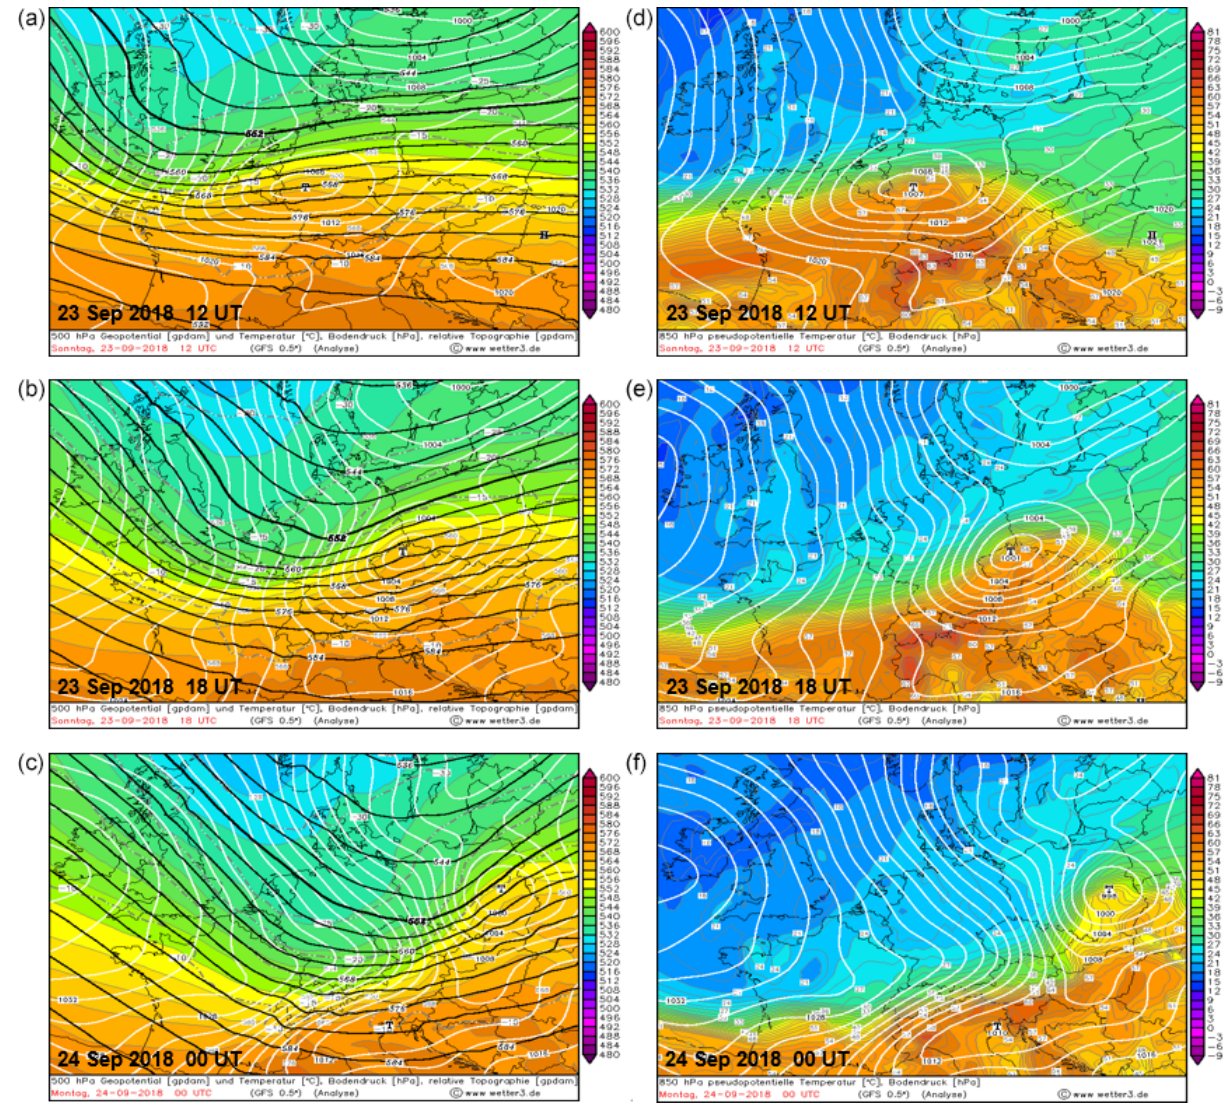
Figure 3. (a) Distribution of the geopotential field (black lines) and temperature (gray dashed lines) at a level of 500hPa, of the surface pressure field (white lines), and of relative topography 500–1000hPa (color field). The 500hPa is given in units of geopotential decameter (gpdam), the temperature in ◦ C, the surface pressure in hPa, and the 500/1000hPa thickness in gpdam. Isohypses and thickness are 4gpdam apart, isobars 2hPa and isotherms 5 ◦ C. The thickness or difference in heights between the 1000hPa (surface) and 500hPa levels varies by temperature and moisture (is a function of the average virtual temperature); thus, the color field regions depicted the average temperature of the troposphere. (Orange/red values indicate warm tropical air, blue/indigo Arctic air.) (b) Analysis of pseudo-equivalent potential tem- perature in the 850hPa pressure level in ◦ C (color field and isotherms – gray lines, 3 ◦ C apart) and surface pressure field (isobars – white lines, 2hPa apart). The pseudo-equivalent potential temperature is conservative in association with the moisture; thus, it allows us to compare temperatures of air masses in the lower troposphere regardless of their